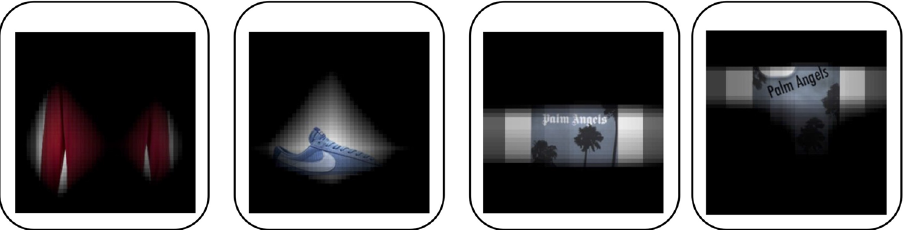
Figure 6. Grounded lexical knowledge. Maps are easy-to-use probes into the model fashion knowledge. Left to right : localization map for “long sleeves” on a red polo; sneakers and the map for “Nike”, a phone cover and the map for “Palm Angels”; the same phone cover and map, when the logo is written with an out-of-distribution font in a new spot.